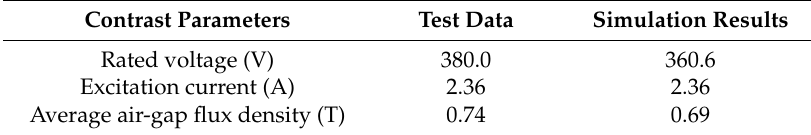
Figure 7. Magnetic flux density distribution of the no-load generator. Table 3. Data for rated running test and simulation